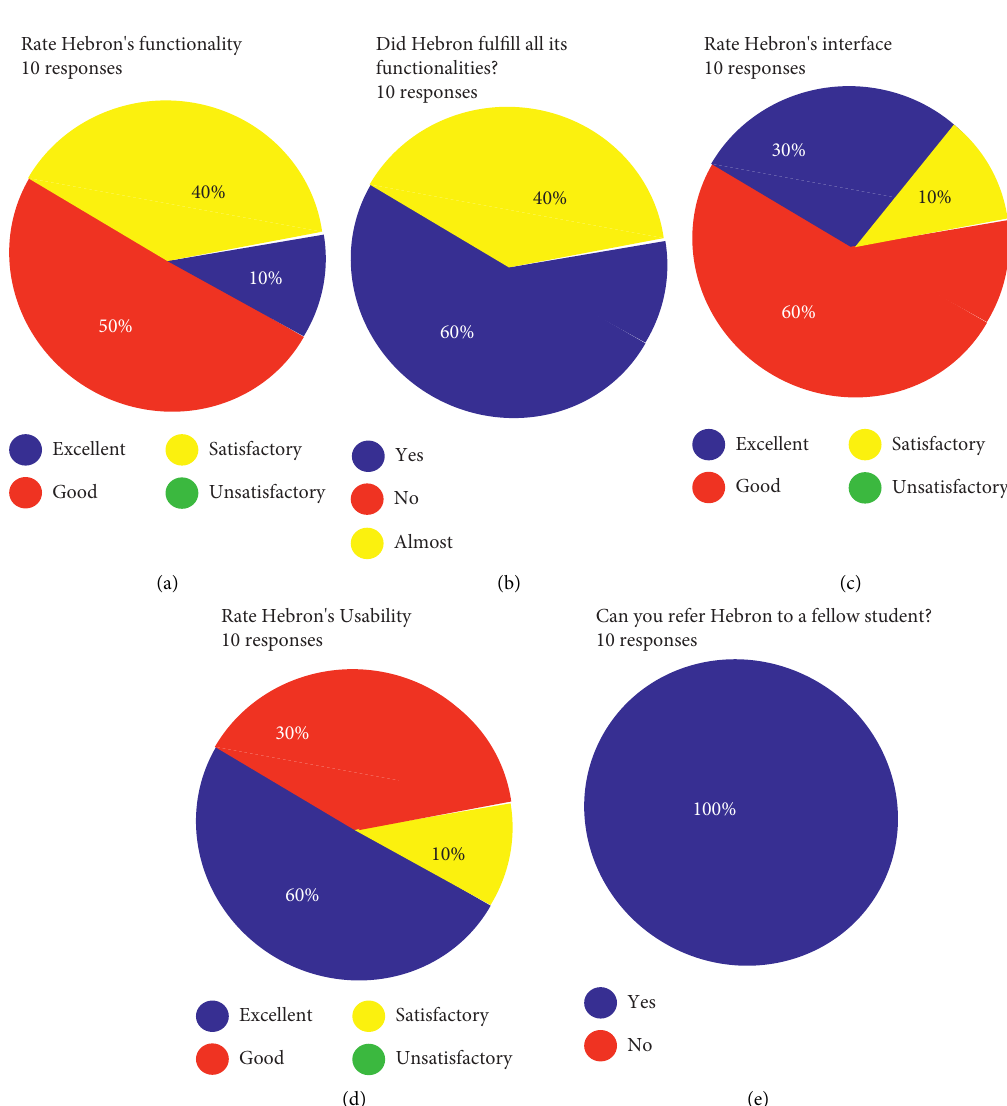
Figure 10: (a) shows that about 50% of users thought that Hebron’s functionality was good and satisfactory. (b) suggests that Hebron fulfilled about 60% of its functionality. (c) shows that 60% of users rated Hebron’s interface as good. (d) Usability Rating. (e) shows that all the testers (100%) thought that Hebron was highly recommendable.